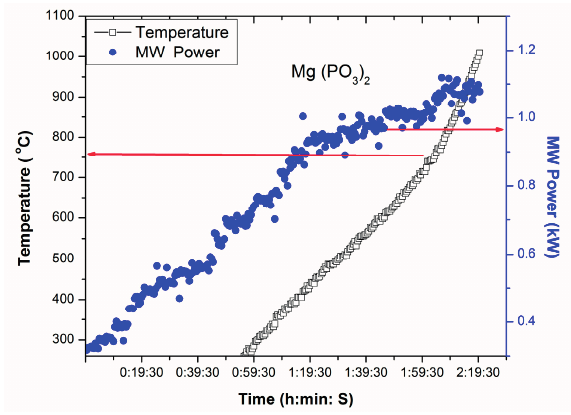
Figure 4. T-P-t profile of Mg(PO 3 ) 2 under direct microwave